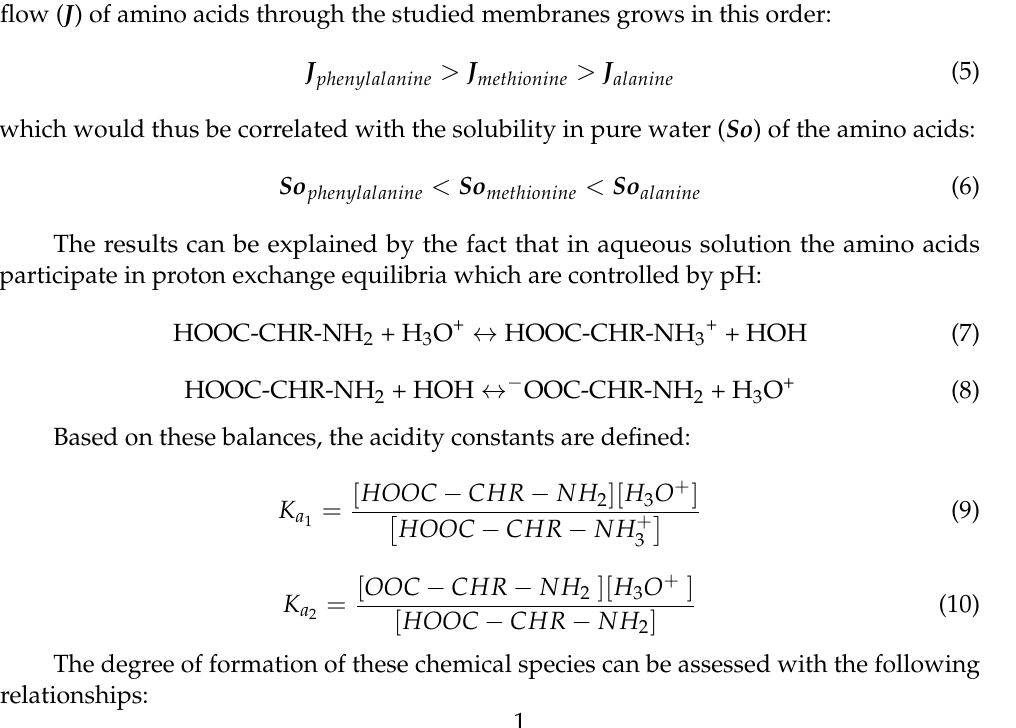
Figure 18. The phenylalanine extraction efficiency EE (%) variation versus the temperature of source phase (SP) for the prepared membranes.